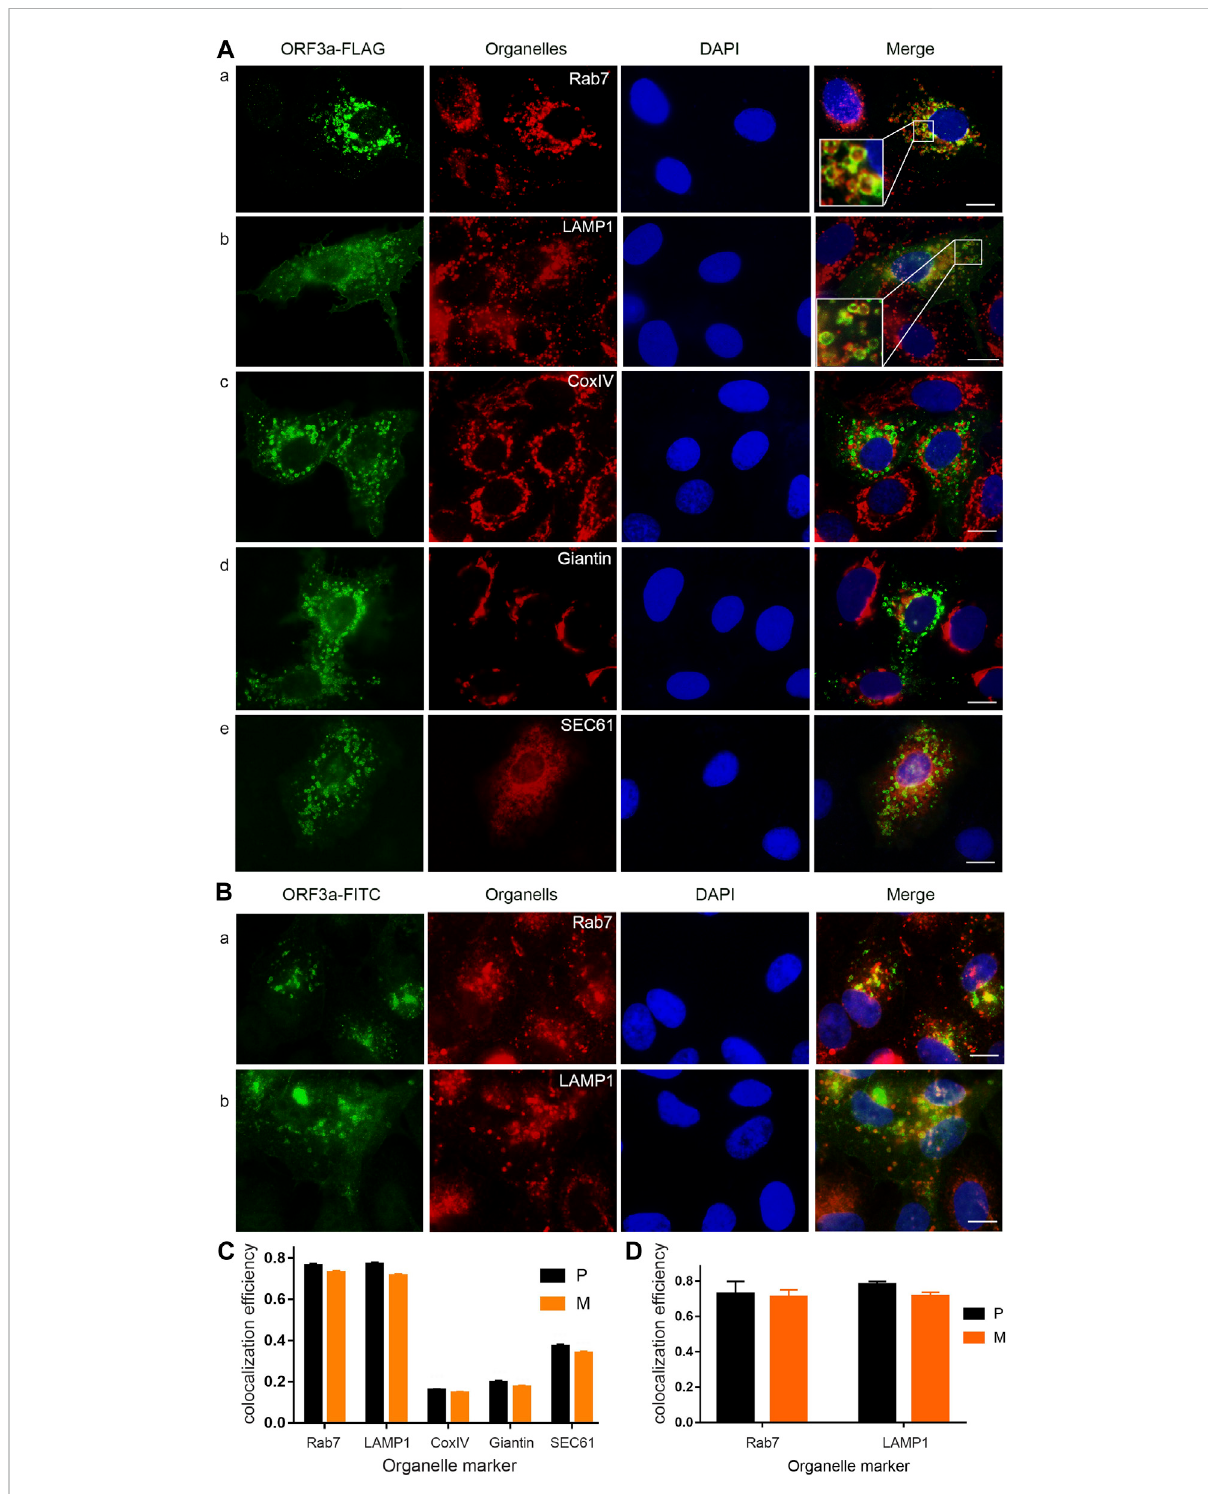
FIGURE 1 SARS-CoV-2 ORF3a protein localizes predominantly on the membranes of lysosomes and late endosomes. (A) Expression of ORF3a in the A549 cells showed abundant presence of ORF3a in late endosomes (P = 0.76 ± 0.04) as labeled by late endosome-speci fi c marker Rab7 (a) and lysosomes (P = 0.77 ± 0.05) by LAMP-1 (b), with minor presence in mitochondria (P = 0.16 ± 0.02) by CoxIV (c), Golgi apparatus (P = 0.20 ± 0.04) by Giantin (d), and ER (P = 0.37 ± 0.04) by SEC61 (e). Enlarged image inserts in (A) and (b) show predominant association of ORF3a on